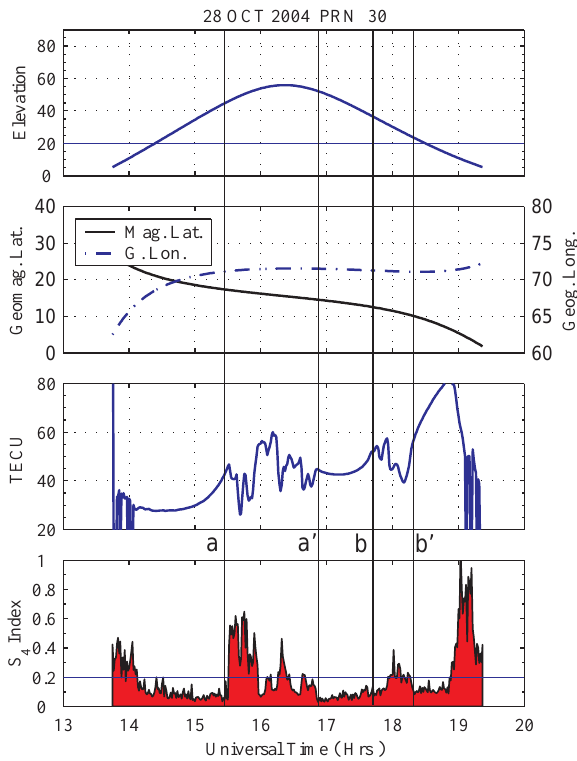
Fig. 3. Variation of TEC and S 4 on 28 October 2004 for PRN 5. A series of depletions in TEC are seen. The S 4 index increases only when the depletions occur. The rest of the labels are the same as in Fig. 1.